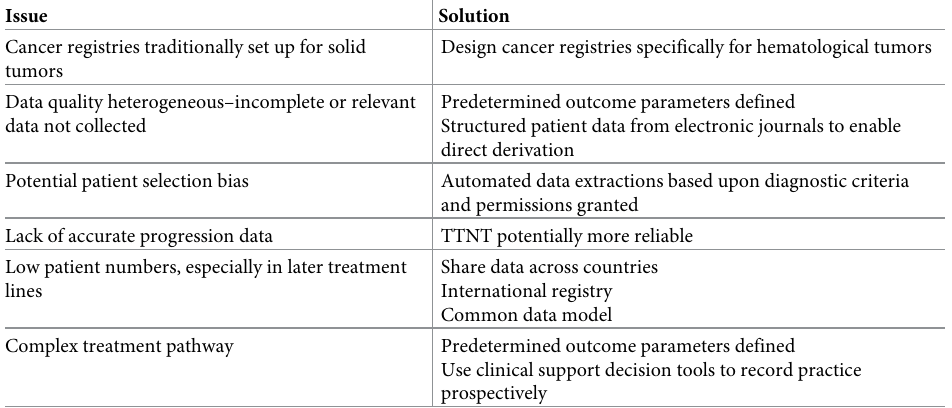
Table 2. Challenges in using a retrospective study design to understand real-world experience and potential solutions. Issue Solution Cancer registries traditionally set up for solid